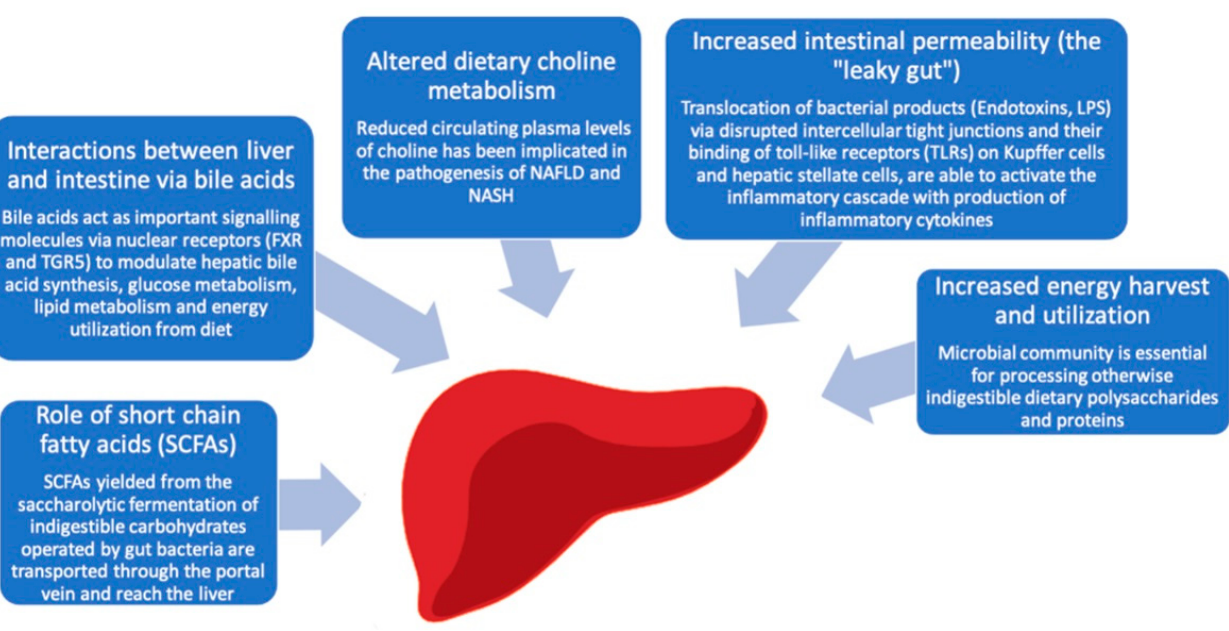
Figure 1. Gut microbiota related mechanisms implicated in the pathogenesis of NAFLD/NASH. Intestinal microbiota can contribute to the development of hepatic steatosis through a variety of mechanisms, including an increased intestinal permeability, effects on appetite regulation and energy extraction from the diet and modulation of bile acids signaling.